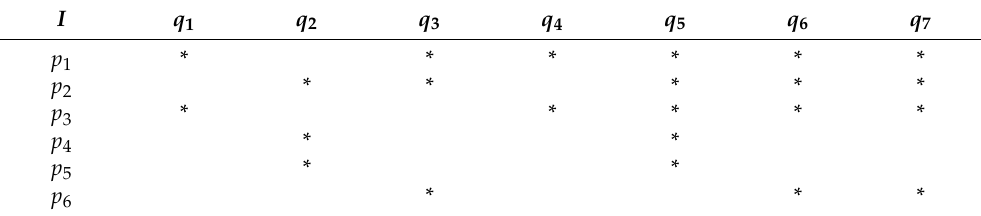
Table 1. A formal context.